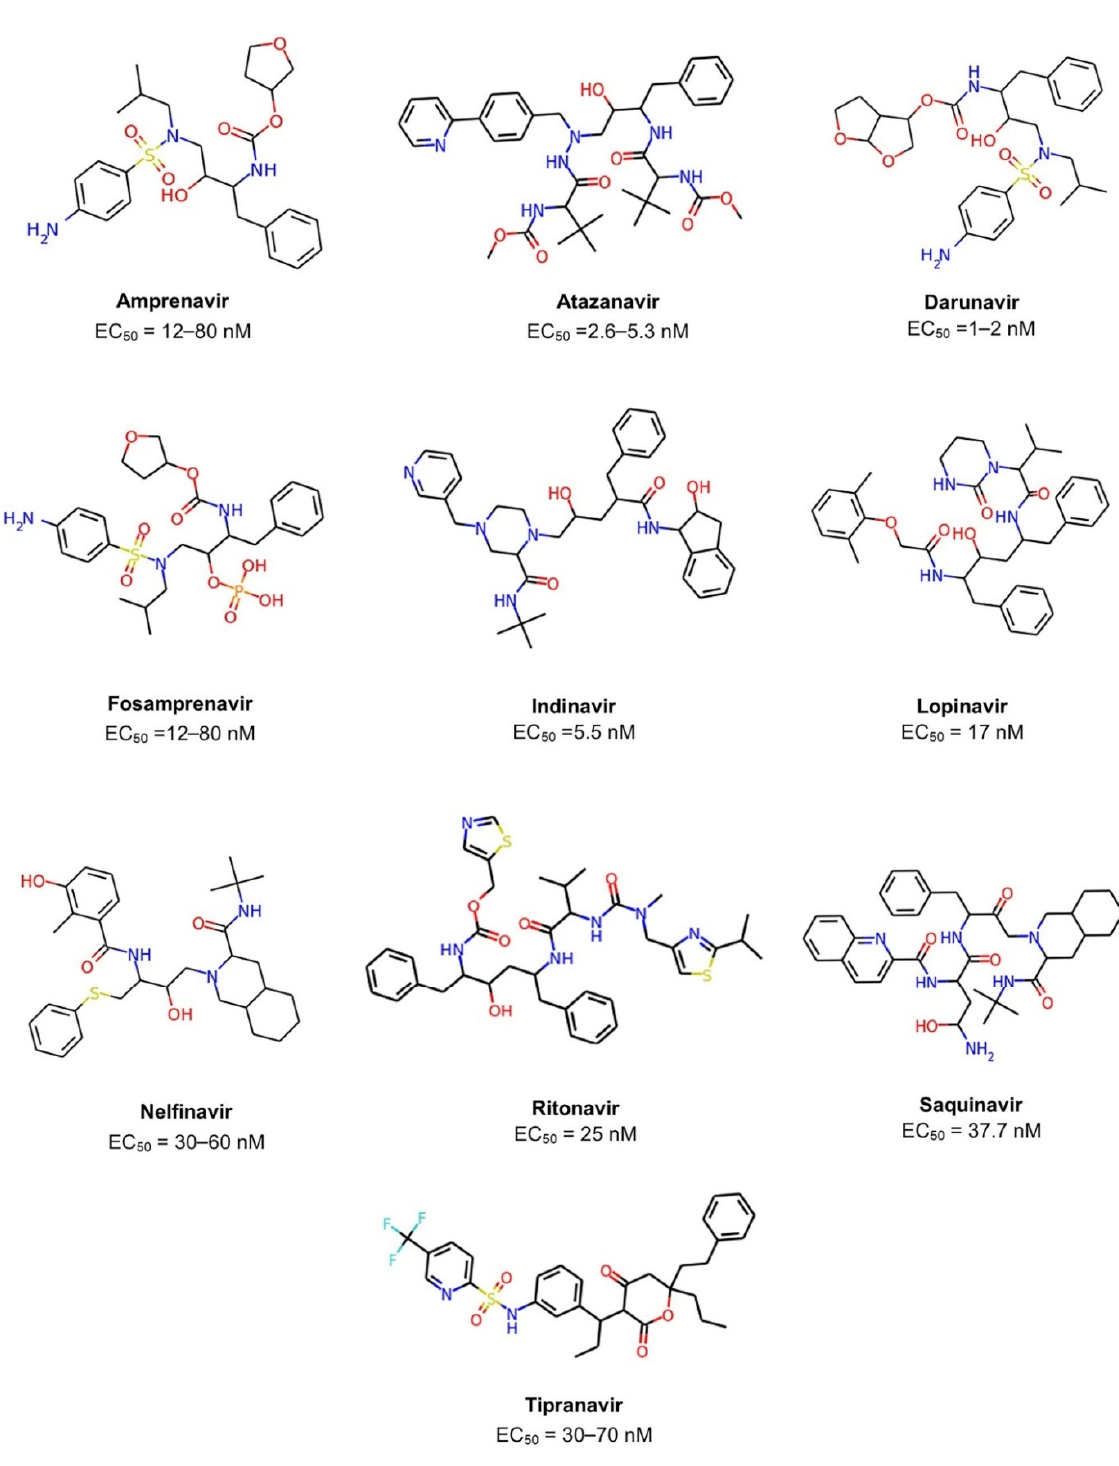
Figure 1. Chemical structures of ten FDA-approved HIV-1 protease inhibitors (Amprenavir, Atazanavir, Darunavir, Fosamprenavir, Indinavir, Lopinavir, Nelfinavir, Ritonavir, Saquinavir, Tipranavir). The EC50 is the concentration of drug required to produce 50% of the maximum possible effect.